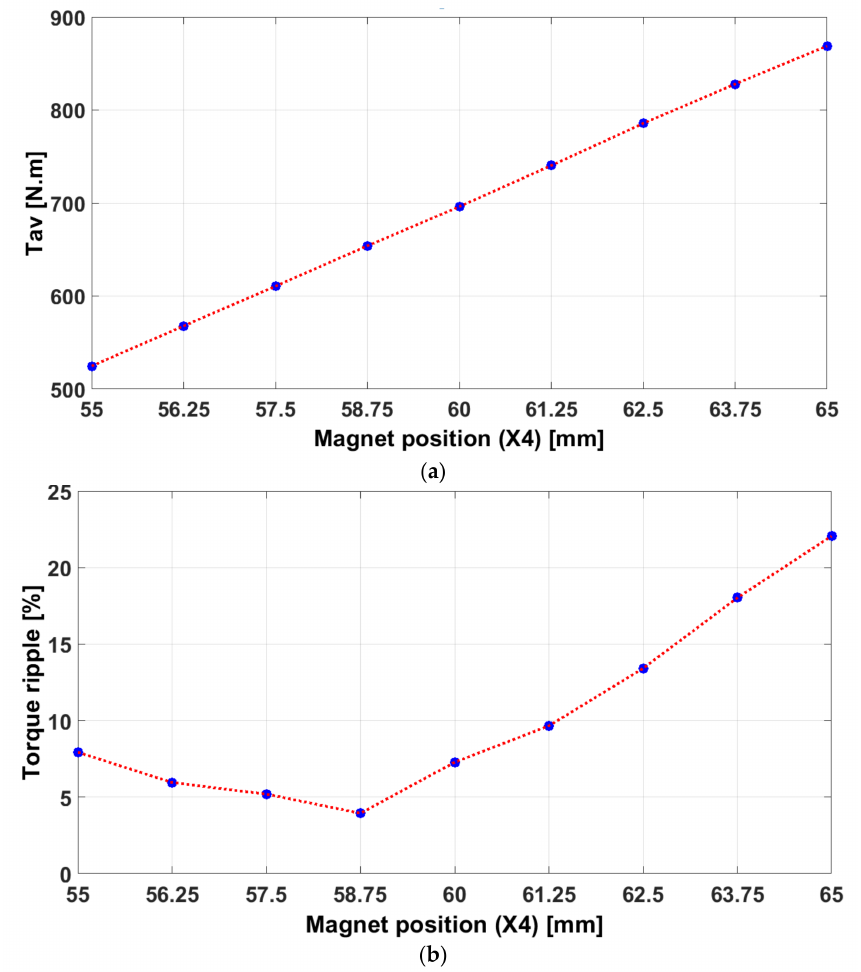
Figure 7. Impact of the central magnet position variation relative to the rotor center on: ( a ) the average torque; ( b ) the torque ripple.